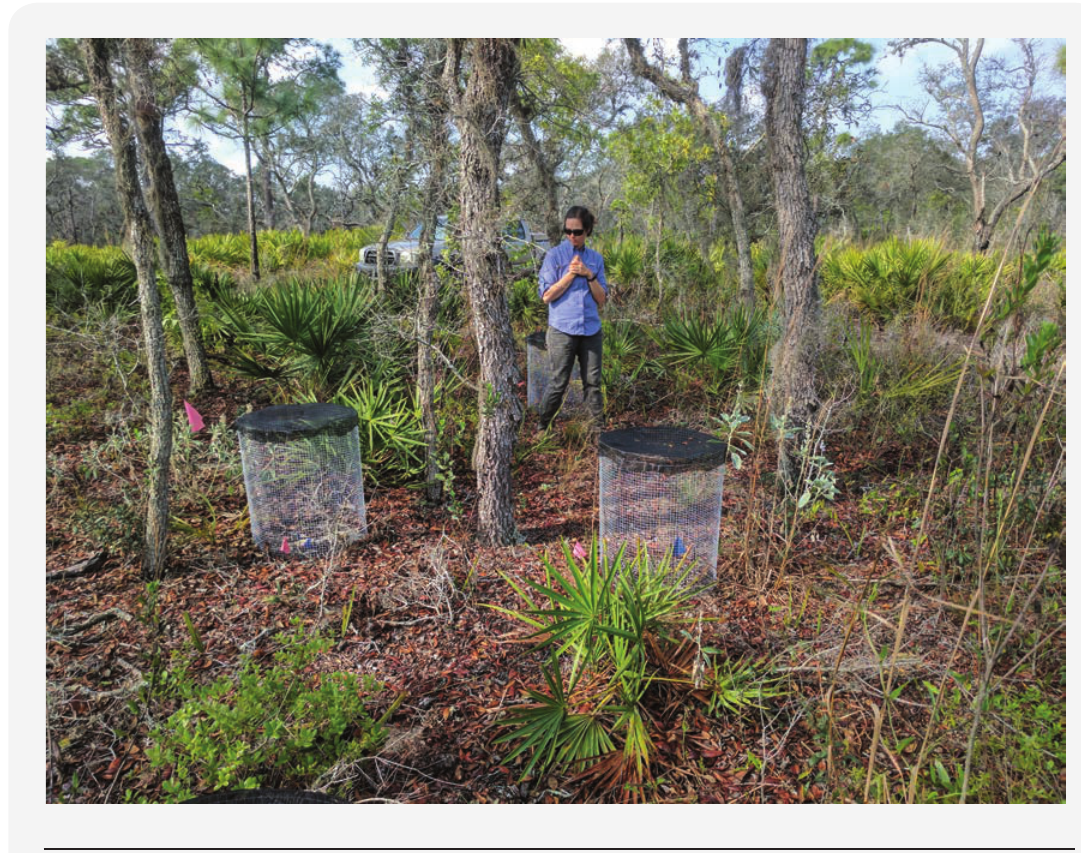
Figure 9. Caged individuals of Ziziphus celata that were reintroduced experimentally. The parentage of these individuals was assessed prior to being transplanted. The genetic data was used to structure the individuals so that they were placed next to individuals with different parents to avoid long-term inbreeding. Photo by Christine